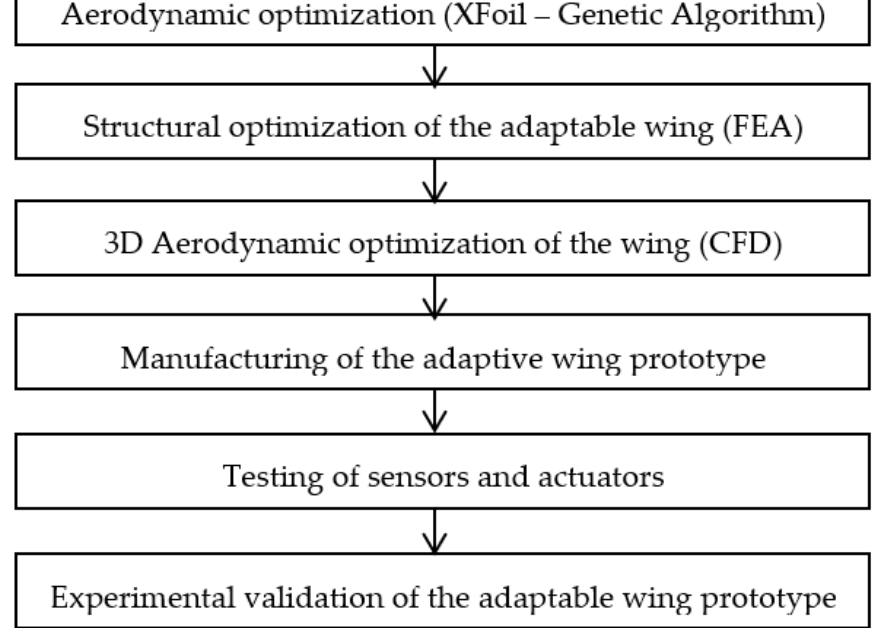
Figure 6. The methodology for the study of an adaptive wing.